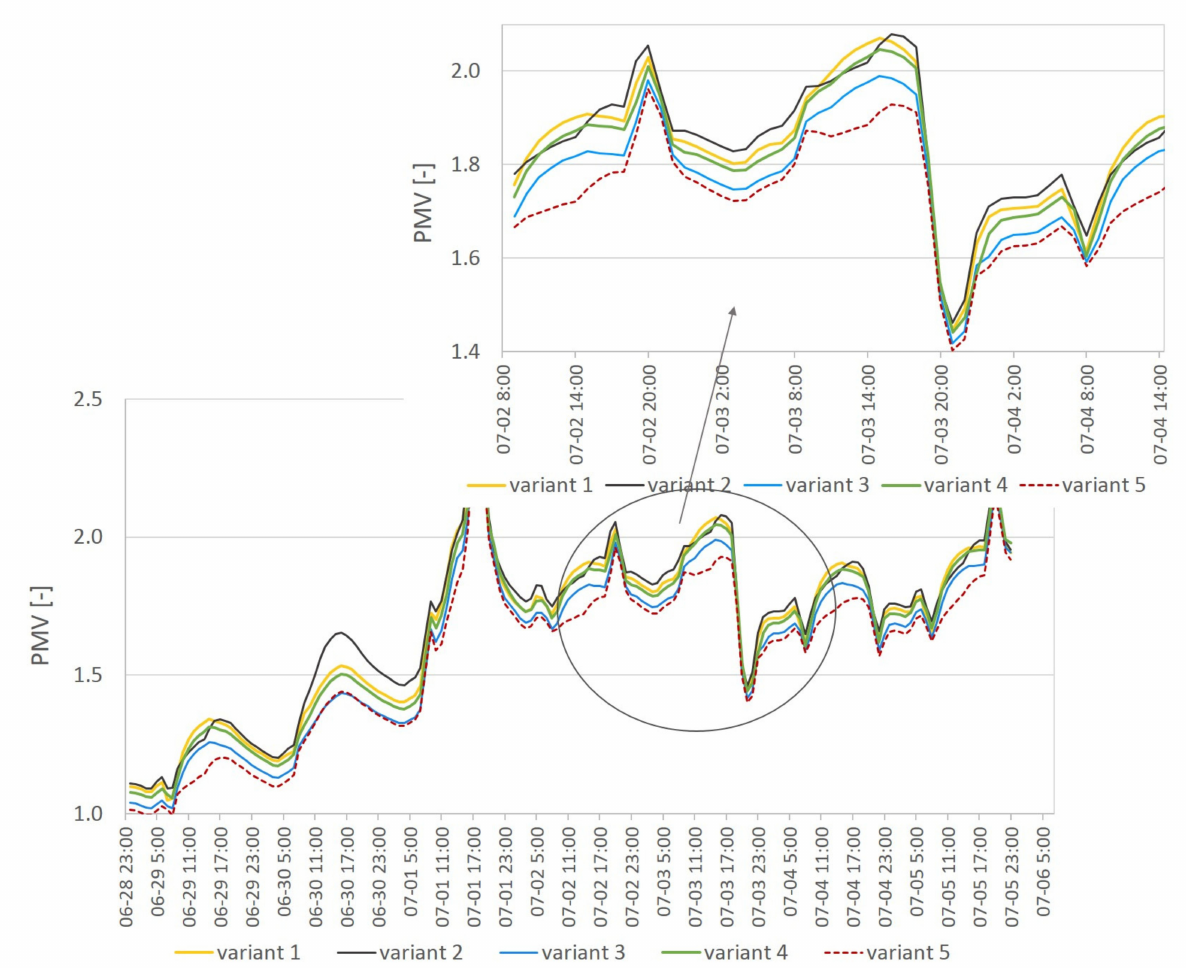
Figure 13. Distribution of PMV values for the selected week. Table 6. Hourly distribution of the PMV index for the adopted simulation